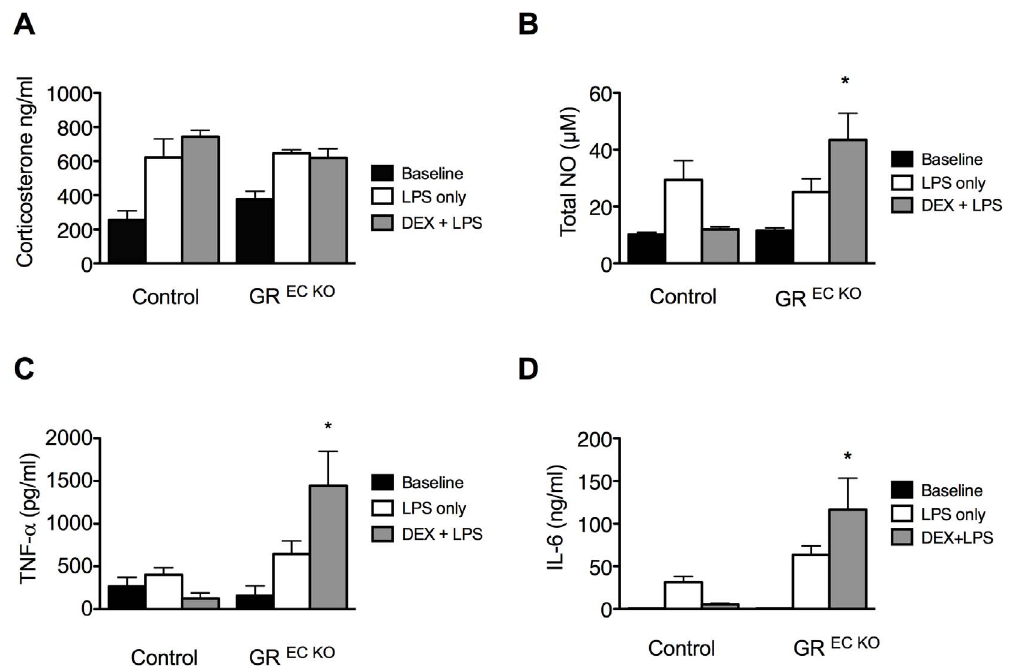
Figure 2. Heightened inflammation in GR EC KO mice following DEX pre-treatment. (A) No differences in corticosterone level were observed between GR EC KO mice and controls for any of the conditions tested. (B) Total nitric oxide levels in GR EC KO mice are increased following DEX + LPS. (C) TNF- a and (D) IL-6 levels are significantly increased in GR EC KO mice following DEX + LPS treatment while they are nearly unchanged from baseline in controls. All blood samples were collected 8 hours after LPS treatment (and 10 hours after DEX pre-treatment, if applicable). *p , 0.05 compared to similarly treated controls.